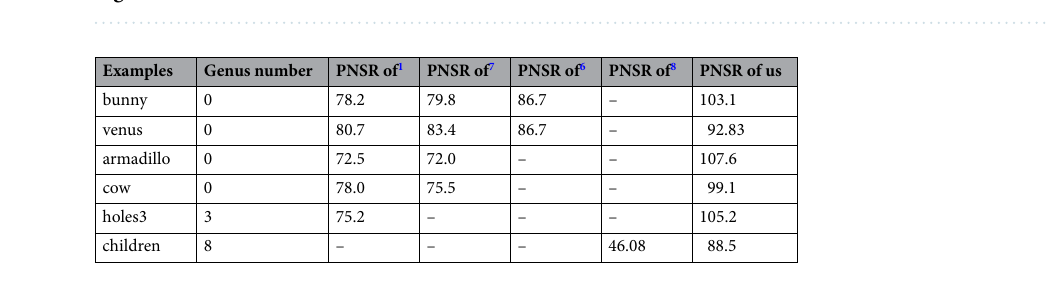
Table 1. Reconstruction error (PSNR)